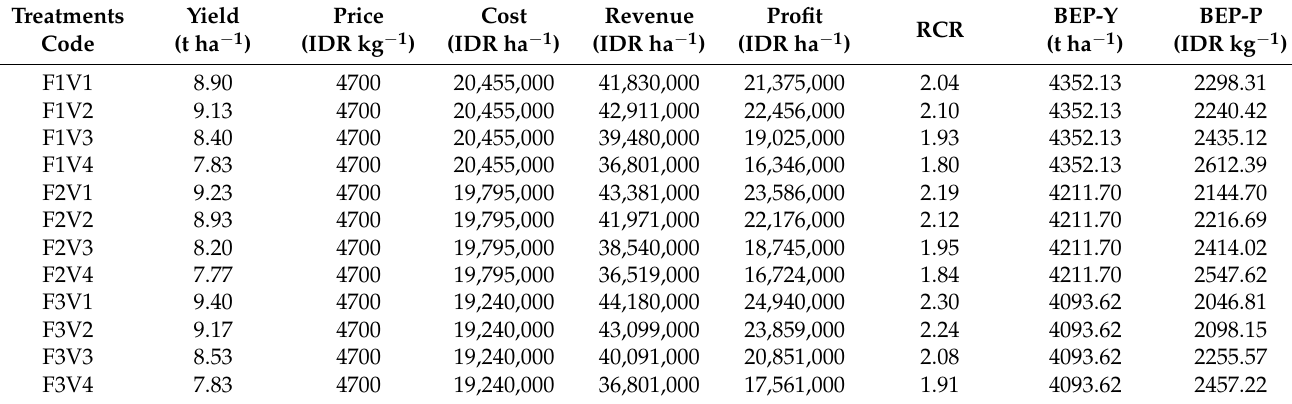
Table 8. The production cost of the study in karst dryland, in Gunungkidul, WS 2019/2020.